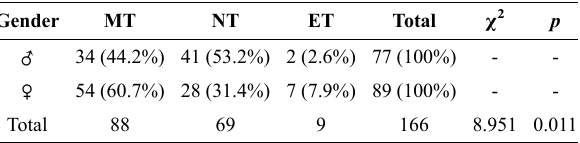
Figure 1 - Frequency distribution of the score obtained on the HÖ-MEQ. The dashed line indicates men, and the solid line indicates women. Clas- sification: evening-types ( ≤ 41), neither-types (42-58), morning-types ( ≥ 59). Table 1 - Absolute and relative distribution (%) of the chronotypes by gender.